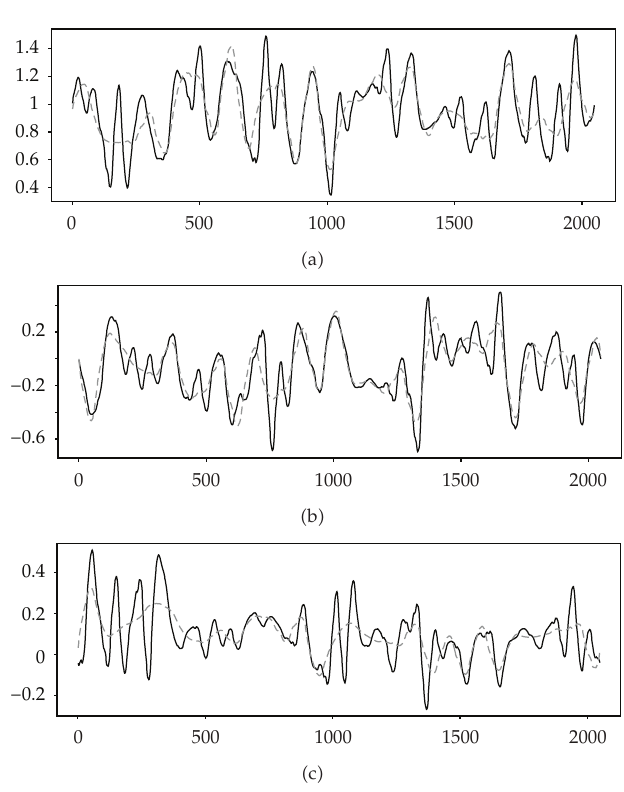
(cid:7) δ (cid:5) u (cid:6) (cid:5) full line (cid:6) and (cid:5) δ 1